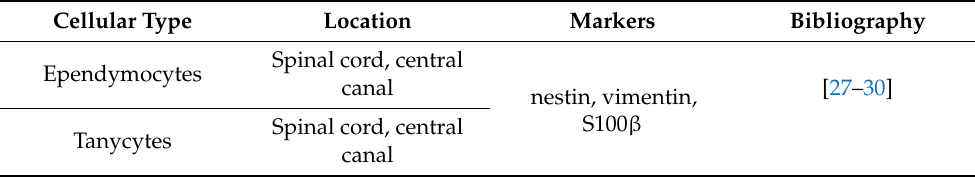
Table 2. Aldynoglia cells in the spinal